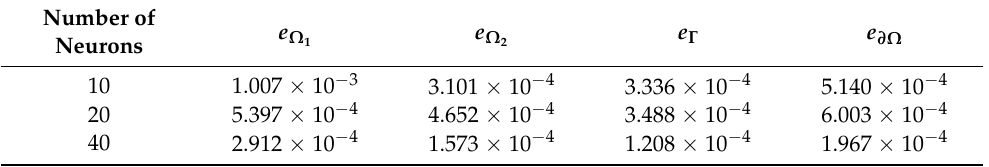
Table 2. Comparison of errors in different terms with different numbers of neurons for Example